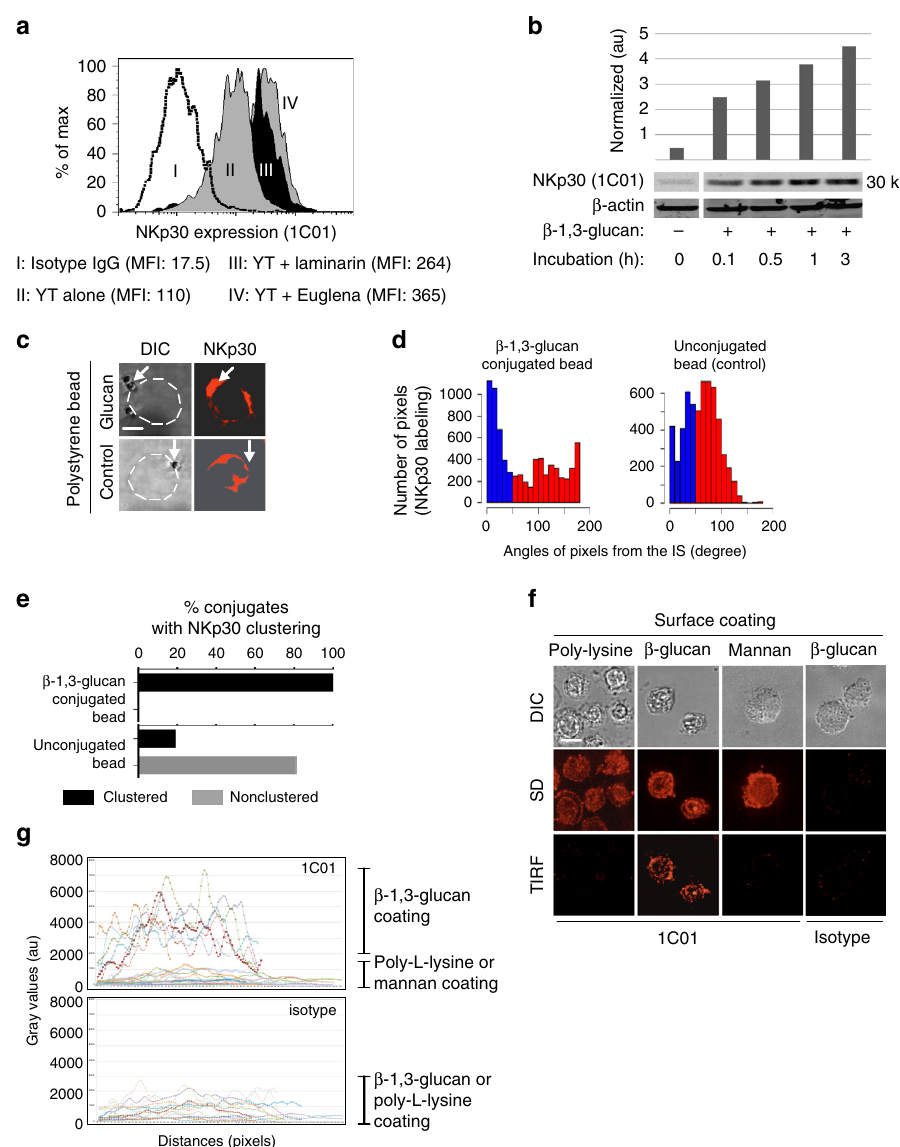
Fig. 5 β -1,3-glucan increases expression and clustering of NKp30 in NK cells. a NKp30 expression in YT cells in response to β -1,3-glucan. YT cells were treated with β -1,3-glucan (III and IV) and expression of NKp30 using 1C01 was compared to untreated cells (I), or untreated cells labeled with isotype control (II). b Western blot analysis of NKp30 expression in YT cells in response to β -1,3-glucan. YT cells were incubated with or without β -1,3-glucan for various times. The experiment was repeated three times with similar results. c NKp30 labeling at the synapse between a representative single YT cell and a single β -1,3-glucan-conjugated bead. 1C01 was used to label NKp30. The location of the bead is shown with a white arrow. Bar = 5 µ m. d Proximity of NKp30 expression in relation to the radius de fi ned by the center of the IS ( n = 21 cells) in panel c . The method for determining the angle is illustrated in Supplementary Fig. 6C. Clustering was de fi ned when the peak of fl uorescence was at an angle < 45° (blue bars in the left). e Frequency of NKp30 clustering of all YT cell conjugates with β -1,3-glucan-conjugated or unconjugated beads as analyzed in panel c , as de fi ned in panel d . f TIRF microscopic analysis of NKp30 expression at the interface between YT cells and β -1,3-glucan or control. YT cells were loaded into a glass chamber that had been coated with β -1,3- glucan or mannan incubated at 37 °C for 30 min, fi xed and stained for NKp30 using 1C01. Bar = 10 µ m. g Fluorescent intensity of NKp30 from panel f in arbitrary units. Distance is de fi ned in Supplementary Fig. 6A-B. All experiments were repeated three times with similar results. TIRF total internal re fl ection fl uorescence, poly- L -lysine coating alone or mannan coating served as control, Au arbitrary unit, Arrow bead, SD spinning disc microscopy, DIC differential interference contrast digital image, IS immunological